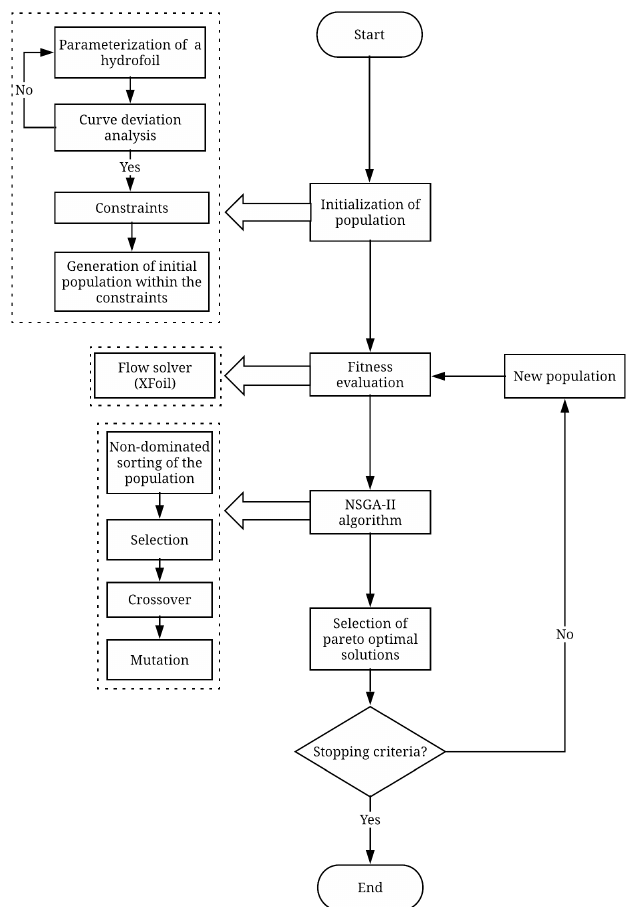
Figure 1. Flowchart of optimization